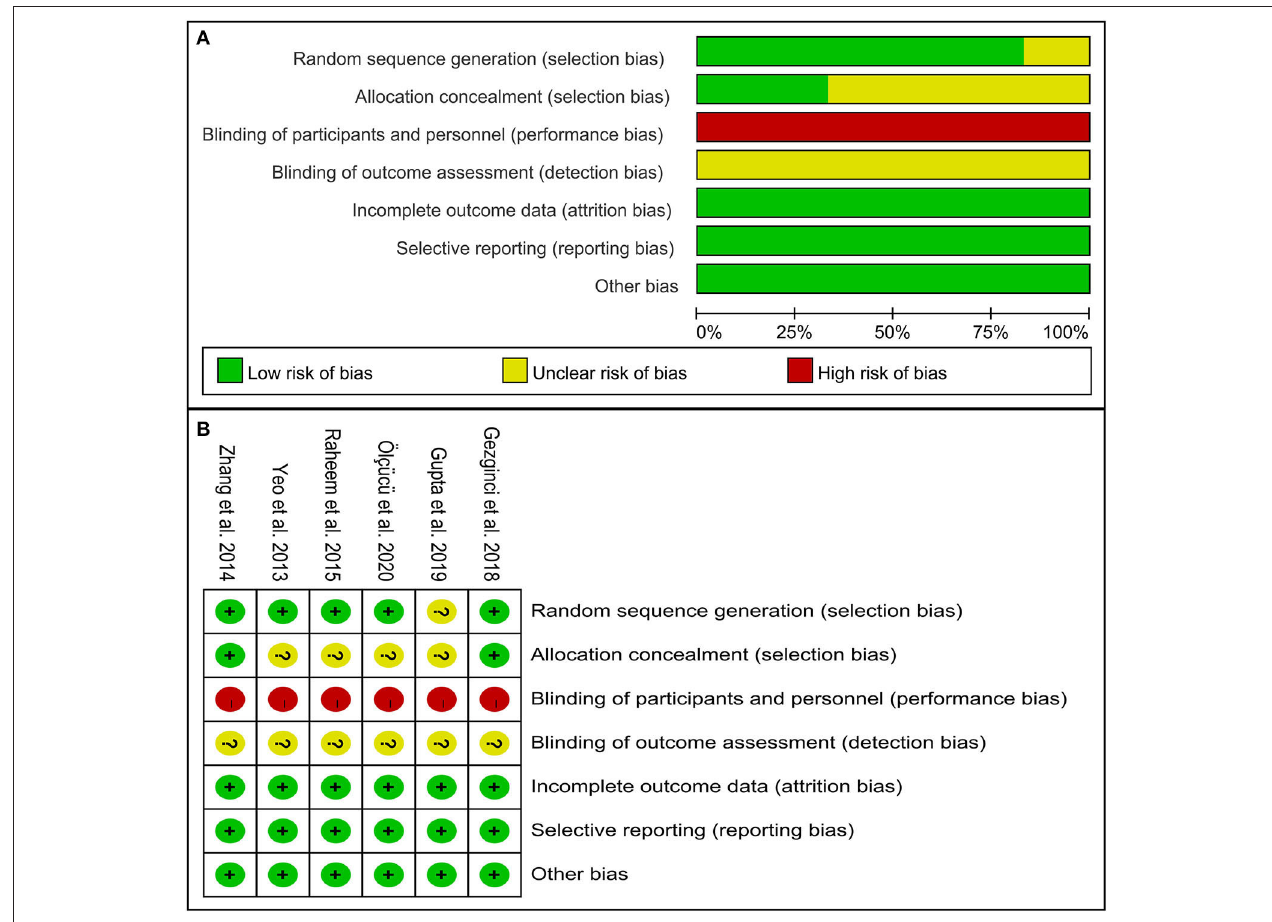
FIGURE 2 | The methodological quality of studies included in this study. (A) Risk of bias graph. (B) Risk of bias